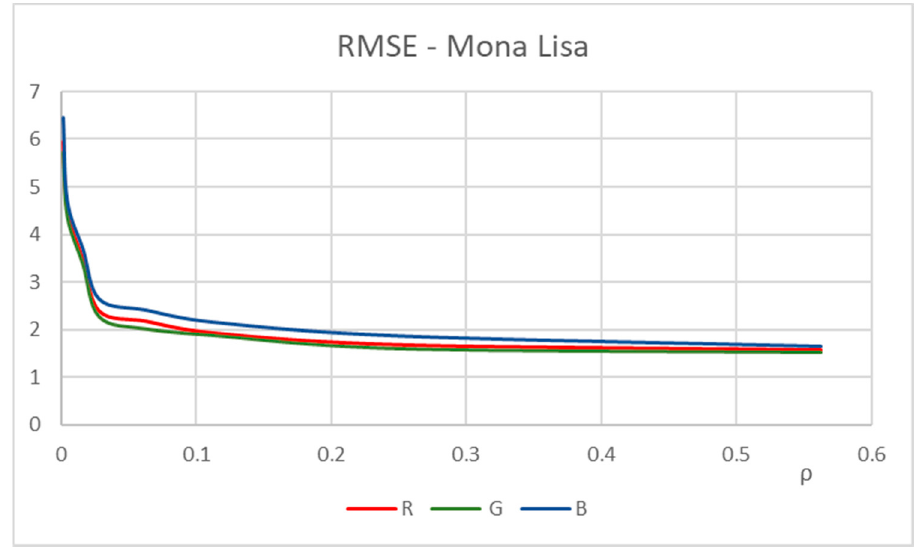
Figure 7. Mona Lisa—RMSE trend in the three band.